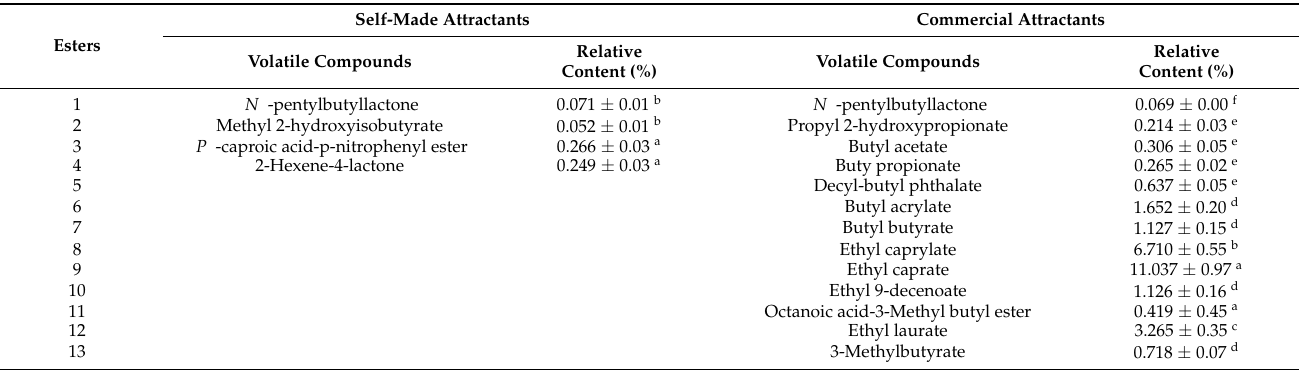
Table 6. Esters and other substances in self-made and commercial attractants (percentage of the total peak